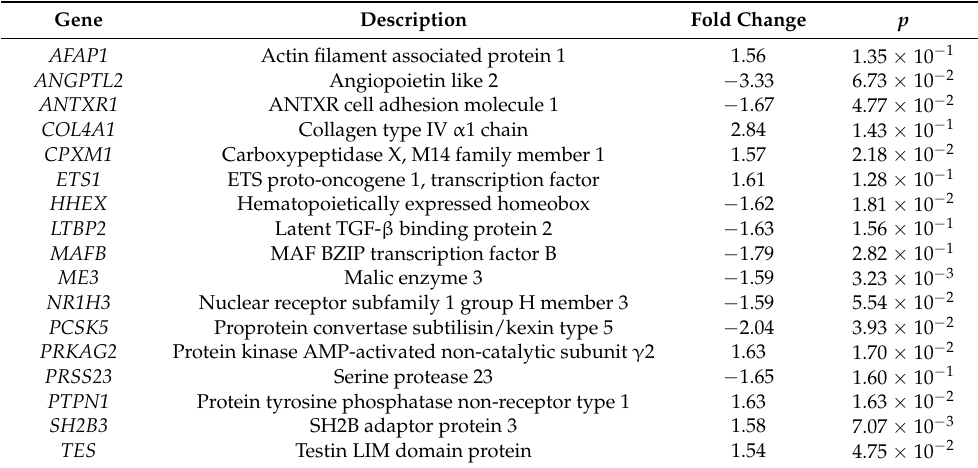
Table 2. Intraocular Pressure-Associated Genes Differentially Expressed in Primary Open-Angle Glaucoma-Affected Human Schlemm’s Canal